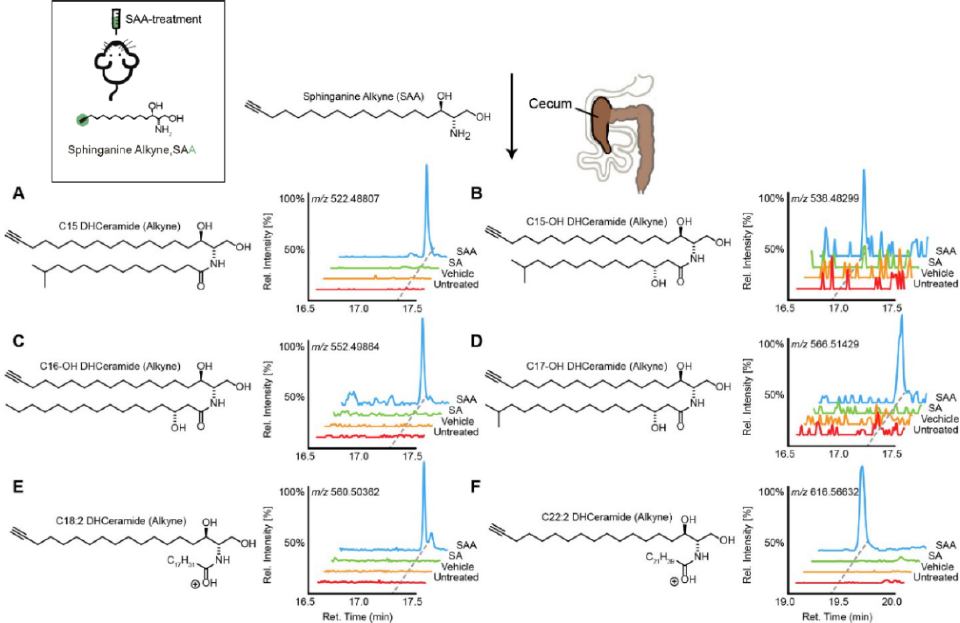
Figure 1. Transformation of dietary sphinganine into dihydrocermides by the gut microbes. Here, sphinganine alkyne (SAA) was given to mice by oral gavage (five consecutive days), then the fecal content from mice was collected and metabolic consequences of SAA exposure were determined using high-resolution mass spectrometry ion chromatograms. The authors showed a distinct cecal lipidome chromatograms for mice that orally treated with SAA (blue), which contained the alkyne-bearing ( A ) C15-, ( B ) C15OH-, ( C ) C16OH-, ( D ) C17OH-, ( E ) C18:2- and ( F ) C22:2- dihydrocermides. However, these dihydrocermides were absent in treatments with sphinganine (SA, green), vehicle or no treatment (red). Figure adapted from [40] , with permission under CC BY 4.0 license.